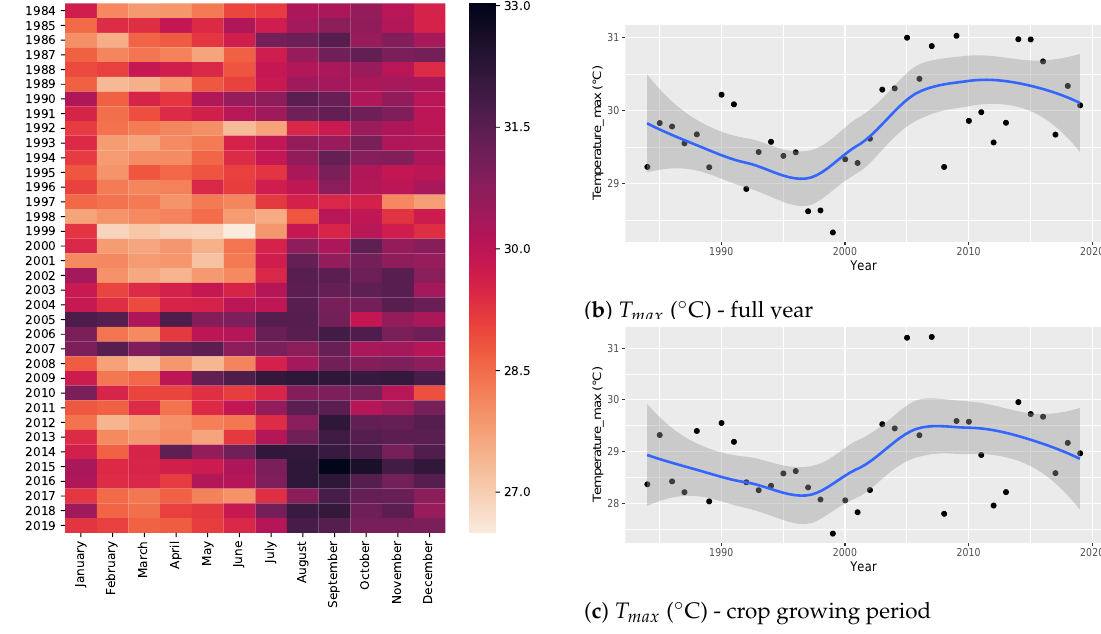
Figure A13. Time series of average maximum temperature ( ◦ C) in Manabi from 1984 to 2019. ( a ) Heat-map of T max ( ◦ C) per each month and year. The color scale represents the temperature in ◦ C. ( b ) T max ( ◦ C) averaged during the full year. ( c ) T max ( ◦ C) averaged during the maize crop growing period in Ecuador (January–May). Each dot represents one record, the blue line shows the smoothed time series and the shaded area represents the 95% confidence